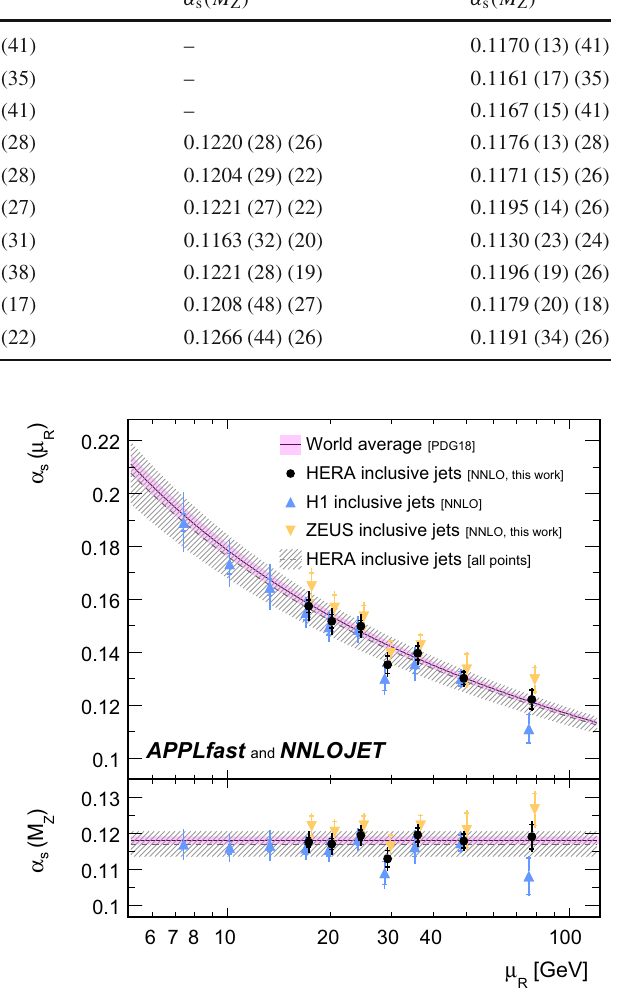
Fig. 6 Results for α s ( M Z ) (lower panel) and corresponding values for α (μ ) (upper panel) from fits to inclusive jet data points arranged in s R groupsofsimilar μ R .Theupperpanelisobtainedbyapplyingtheexpec- tationfromtheQCDrenormalisationgroupequation,asitalsoentersthe NNLO predictions. The inner error bars indicate experimental uncer- tainties, and the full error bars the total uncertainty. The upper triangles show results from H1 data, which were previously fit in Ref. [12] and areherepartiallyupdatedwithNNLOpredictionswithhigherstatistical accuracy. The lower triangles indicate the new results from ZEUS data. The full circles show the combined results from H1 and ZEUS data taken together and are labeled HERA inclusive jets. The shaded band indicates the world average value with its uncertainty, and the dashed line and hatched band indicate the result obtained from the fit to all inclusive jet data and its uncertainty